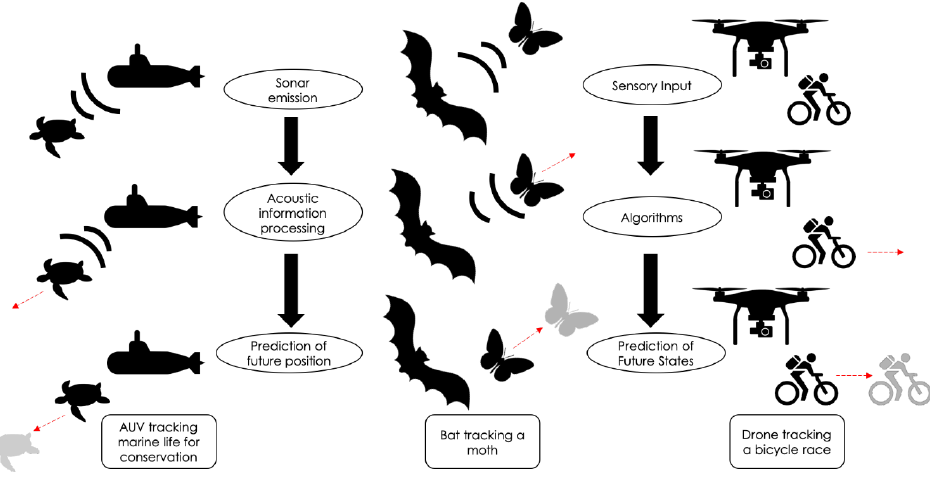
Figure 4. Bats as a biological model to inspire tracking algorithms. Tracking moving targets requires sensory information that can be in the form of echoes (left/center panels) or visual stimuli (right panel). This information must then be processed by computations that allow for the prediction of future states (shown in gray). Man-made systems like Autonomous Underwater Vehicles (AUV) use sonar to track different moving targets, such as marine life and wildlife (left panel). Bats acquire discrete sensory information in the form of echo returns from adaptive sonar emissions; echo snapshots are integrated, to enable the prediction of the future position of a moving insect (center panel). These predictive tracking algorithms can be implemented in technologies that use sonar or other sensory modalities, such as drone videography of a bicycle race (right panel).